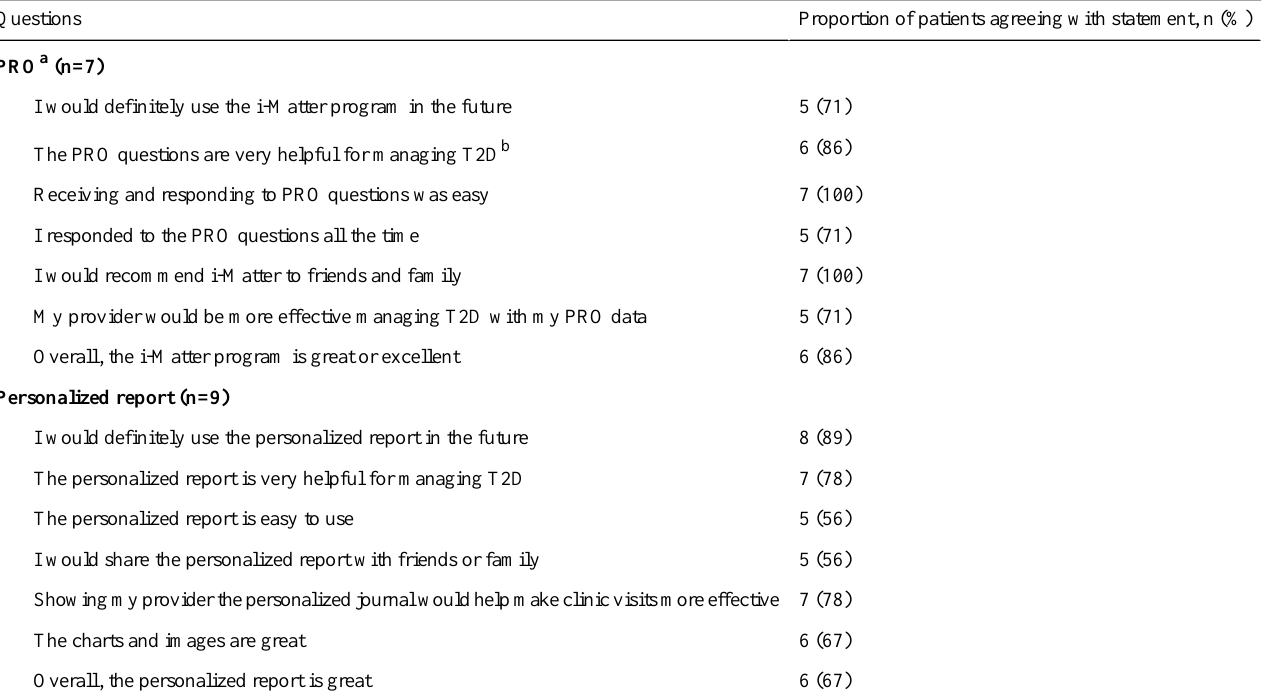
Table 6. Response to technology acceptance model version 3 survey